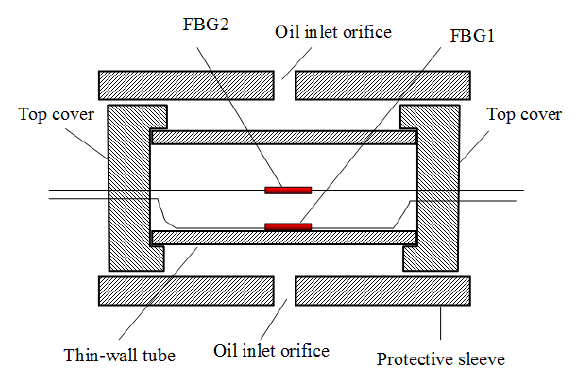
Fig. 4 Structural schematic diagram of the pressure sensor.